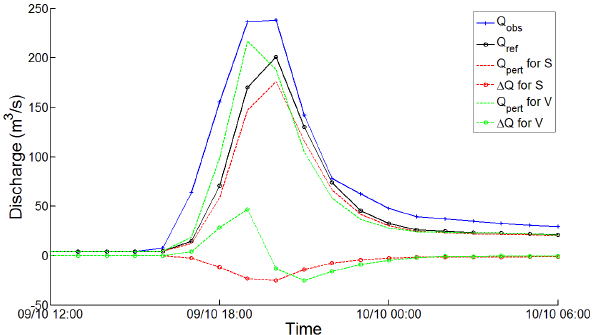
Figure 2. Observed hydrograph (blue curve), assimilated discharge (blue cross), background discharge with S b = 160 mm (black curve) and analysis discharge with S a = 131 mm (red curve) for the October 2001 event.